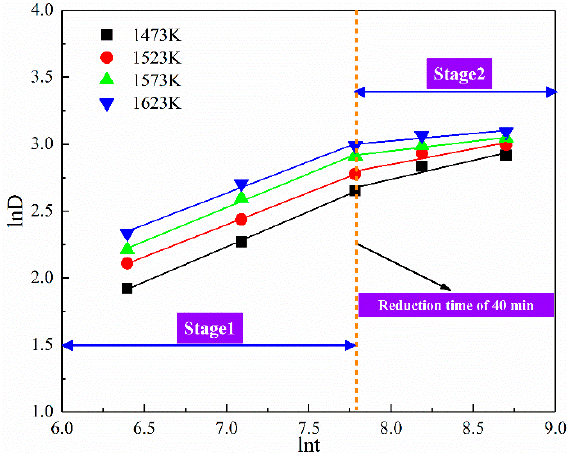
Figure 12. The relationship between ln( D t ) and ln( t